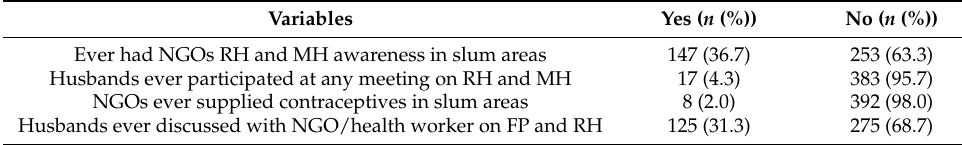
Table 2. Distribution of respondents’ and their husbands’ access to FP, RH and MH services.